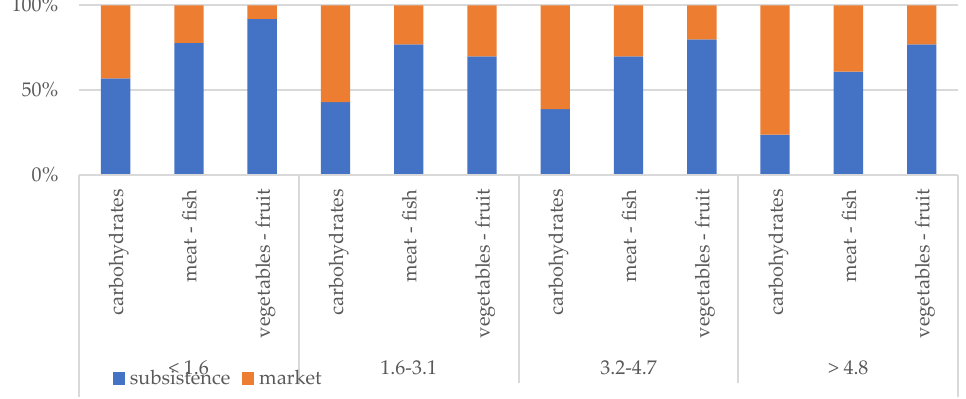
Figure 3. Types and sources of food for landowners at various income levels.